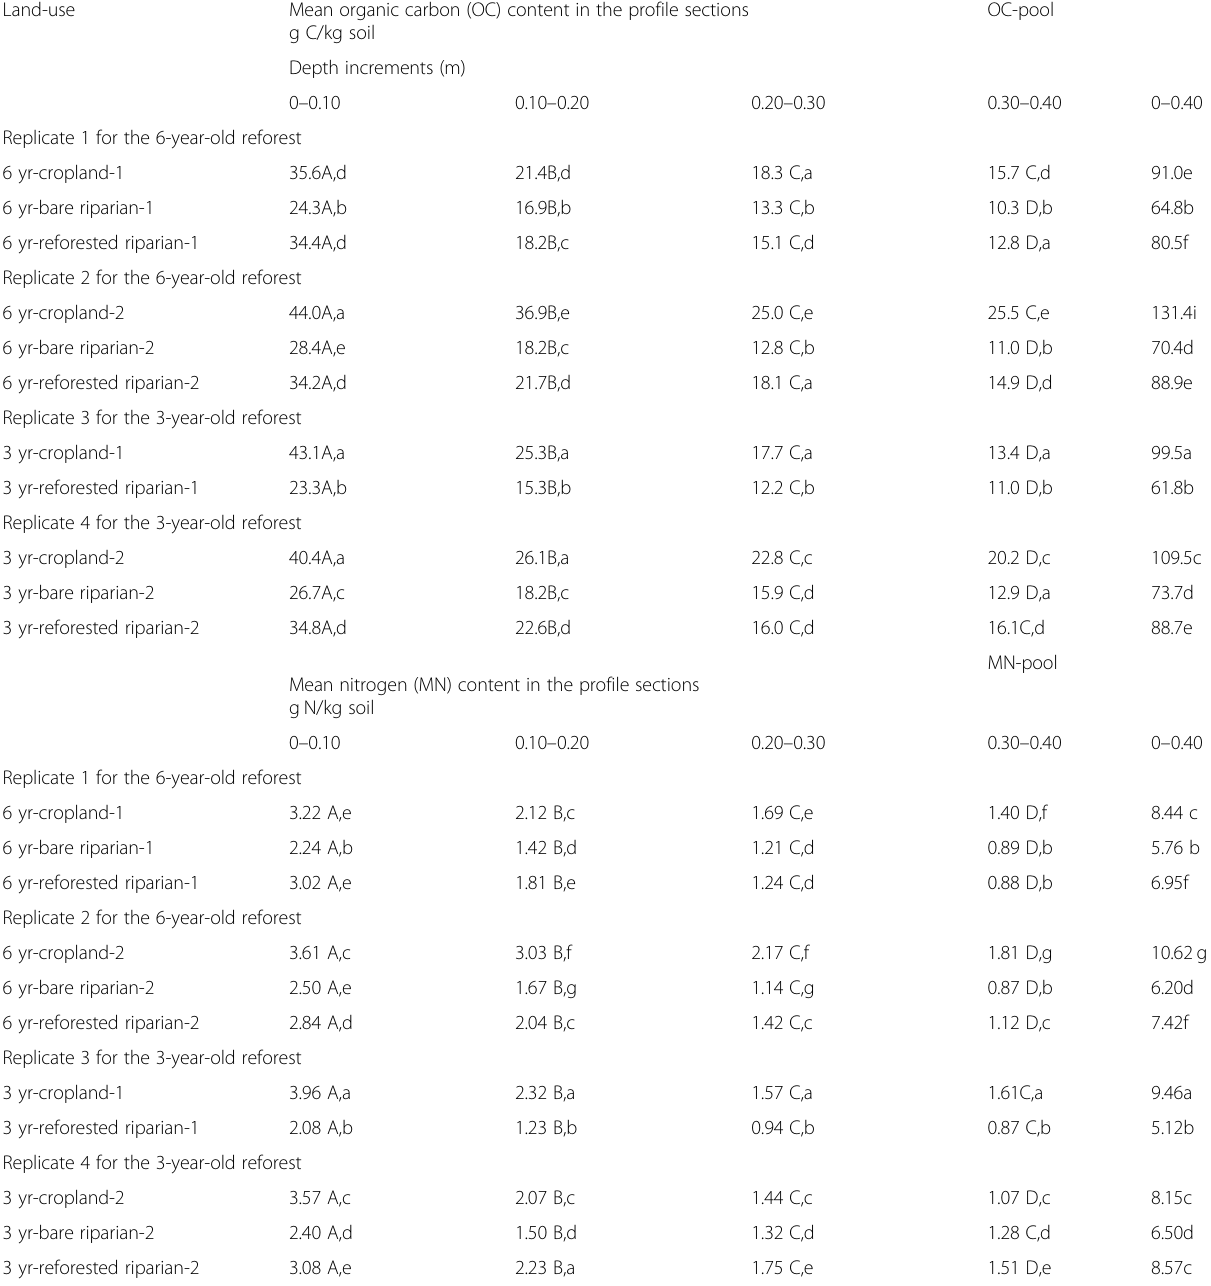
Table 2 The summary of mean separation analysis for soil organic matter (OC) and mineral nitrogen (MN) content distributions at 0.10 m depth increments and for their pools (totals) in soil profiles along the four transects to determine whether these were impacted by different land-use practices and/or the physical location of the transects in the farm. During the experimental design stage, two out of the four transects were considered as replicates for the 3-year-old reforested riparian (RR) and the corresponding cropland (CP) and bare riparian (BR) land-uses and the other two transects as replicates for the 6-year-old RR, CP and BR land-uses Land-use Mean organic carbon (OC) content in the profile sections g C/kg